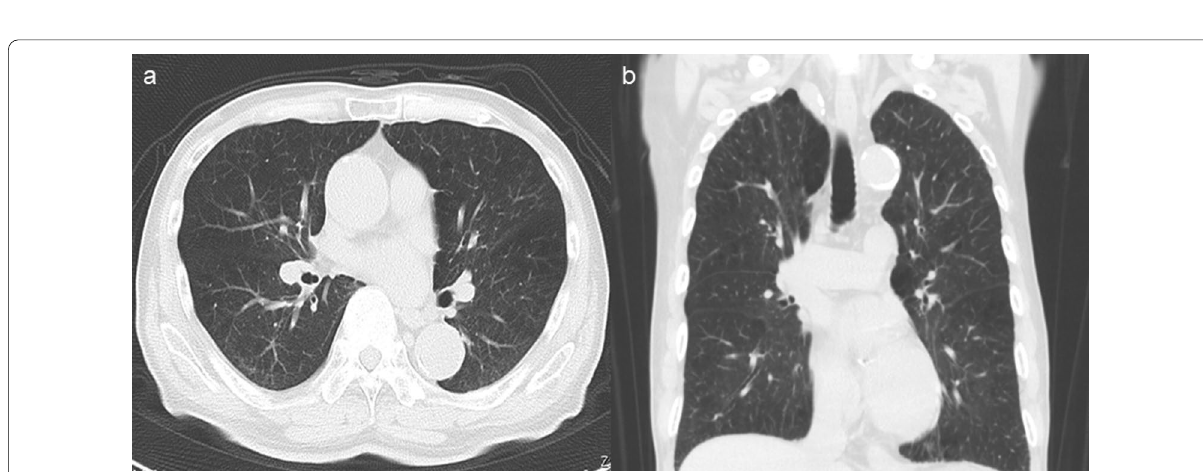
Fig. 2 Chest computed tomography. There were no findings of pneumonia. a Axial view. b Coronal